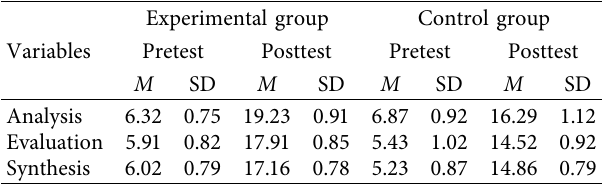
Table 4: Descriptive statistics of high-level learning outcomes. Experimental Variables